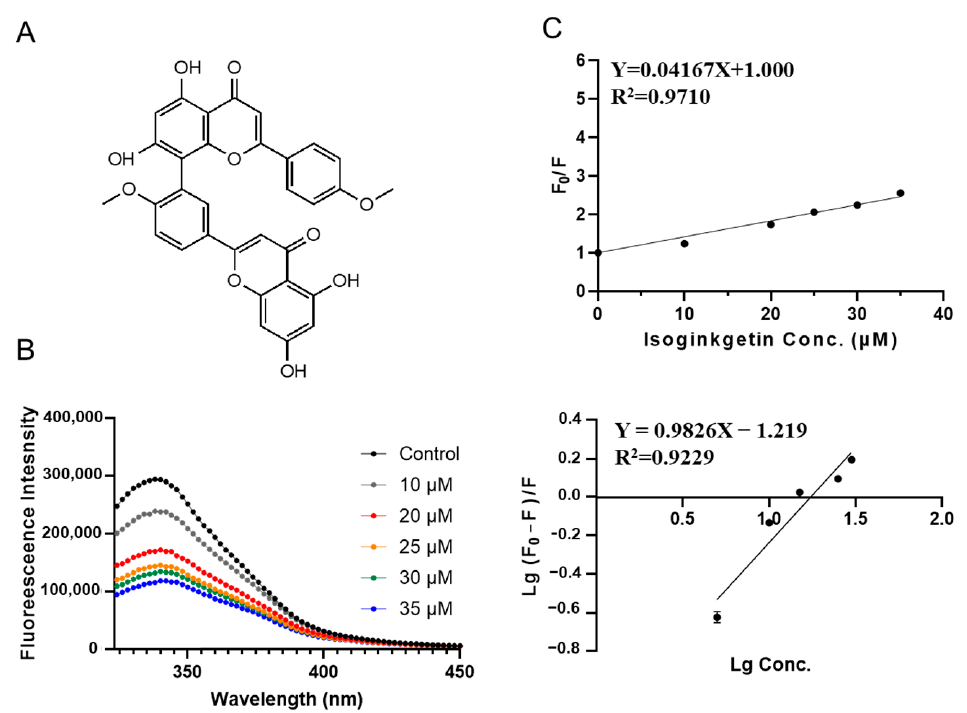
Figure 6. Characterization of SPI–isoginkgetin interaction by fluorescence quenching assay. ( A ) Molecular chemical structure of isoginkgetin. ( B ) The fluorescence emission spectra of SPI titrated with different concentrations of isoginkgetin (10, 20, 25, 30, 35 µ M). ( C ) The